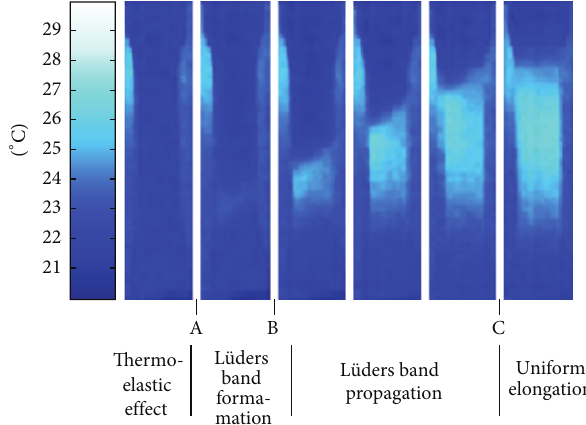
Figure 6: Thermograms of temperature distribution in the defor- mation